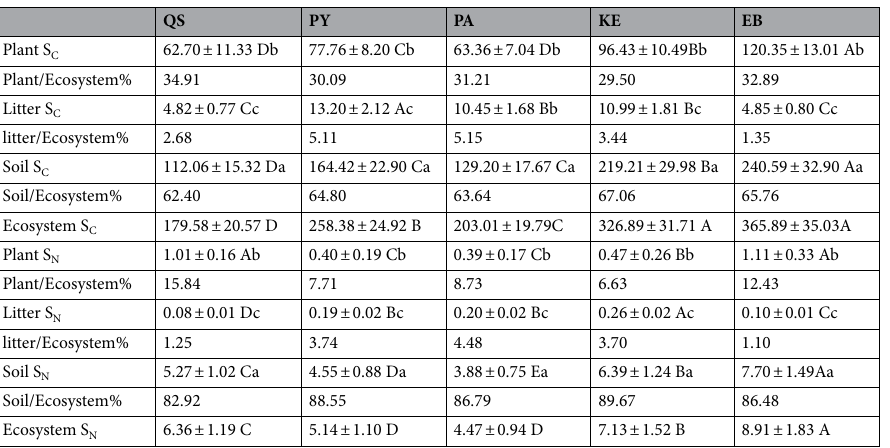
Table 3. S C , (t ha −1 ), S N , (t ha −1 ) and their proportions (%) in the plants, litter and soil in various forest types in the central Yunnan Plateau. Mean values ± standard deviations are illustrated; Different lowercase letters in each row indicate significant differences ( P < 0.05 ) among plant components and the litter layer, and different lowercase letters in each line indicate significant differences ( P < 0.05 ) among forest